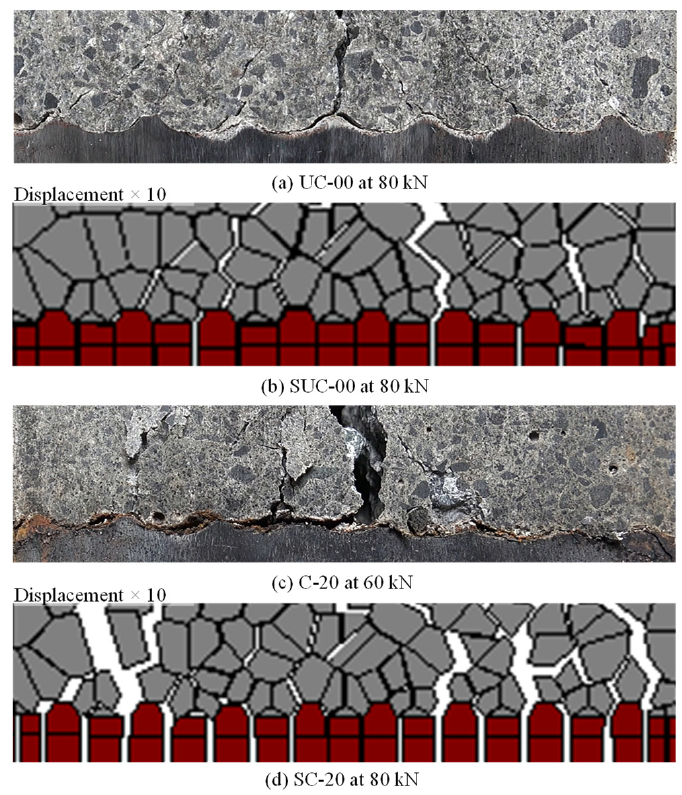
Figure 10. Observed final cracking pattern in: ( a ) uncorroded case in experiment; ( b ) uncorroded case in simulation; ( c ) corroded case in experiment; and ( d ) corroded case in simulation.